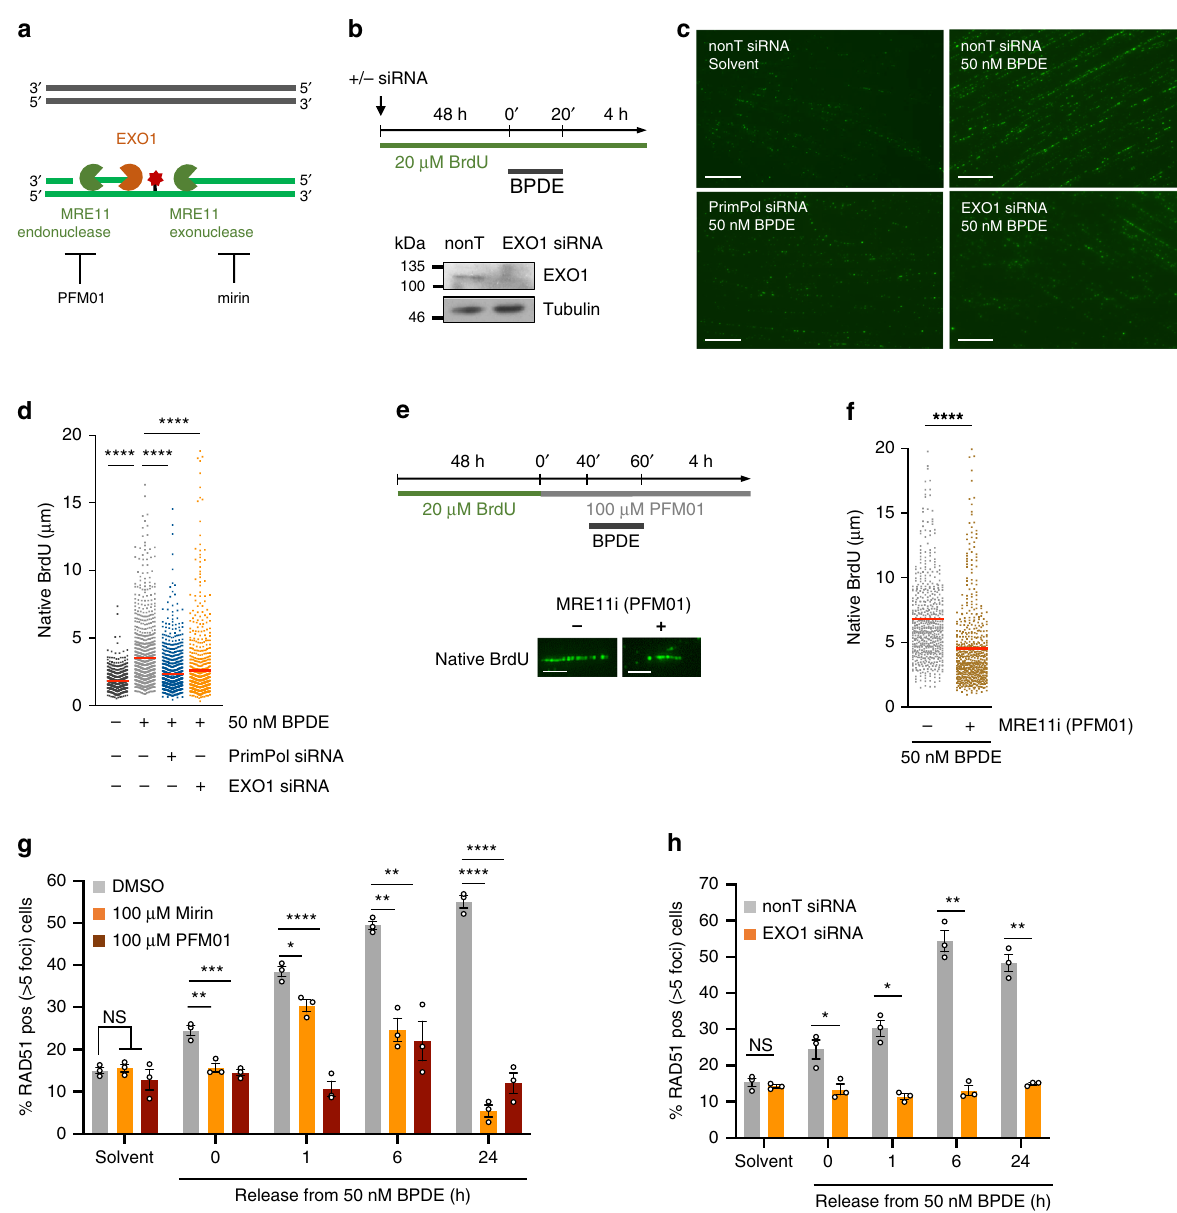
Fig. 4 RAD51 loading at PrimPol-dependent single-stranded DNA gaps requires DNA end resection. a Schematic of MRE11 and EXO1 nuclease activities and targeting by MRE11 inhibitors PFM01 and mirin. b Top: Strategy for SMART analysis of single-stranded DNA quanti fi cations. Bottom: Protein levels of EXO1 and α -Tubulin (loading control) in U2OS cells after 48 h depletion with EXO1 or nonT siRNA. Images are from n = 1. c SMART analysis of single- stranded DNA after release from 20 min of 50 nM BPDE or solvent (-) for 4 h, in presence of nonT (-), PrimPol, or EXO1 siRNA. Images are representative of n = 3. Scale bars: 10 μ m. d Quanti fi cation of SMART analysis after BPDE as in ( c ). Lines represent mean. Data from 3 repeats. e Strategy for SMART analysis with MRE11 inhibitor (MRE11i) PFM01 and representative images of native BrdU tracts. Scale bars: 5 μ m. f SMART analysis of single-stranded DNA after release from 20 min of 50 nM BPDE for 4 h, in the presence or absence of MRE11 inhibitor PFM01. Lines represent mean. Data from 3 repeats. g Percentages of cells with >5 RAD51 foci after release from 50 nM BPDE, in the presence or absence of MRE11 inhibitors mirin or PFM01 as in ( e ). n = 3. h Percentages of cells with >5 RAD51 foci after release from 50 nM BPDE, in the presence of nonT or EXO1 siRNA for 48 h. n = 3 Source data are provided as a Source Data fi le. The means and SEM (bars) of at least three independent experiments are shown. Asterisks indicate p-values (one-way ANOVA for D, G, one-sided Mann – Whitney for F, one-sided student ’ s t-test for H, * p < 0.05, ** p < 0.01, *** p < 0.001, **** p <